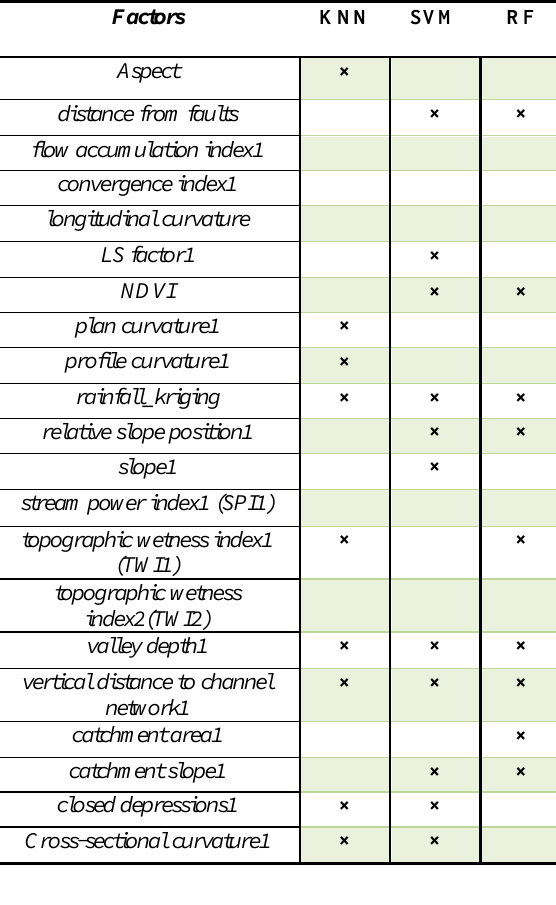
Table 2. Selected factors in each of the KNN, SVM and RF